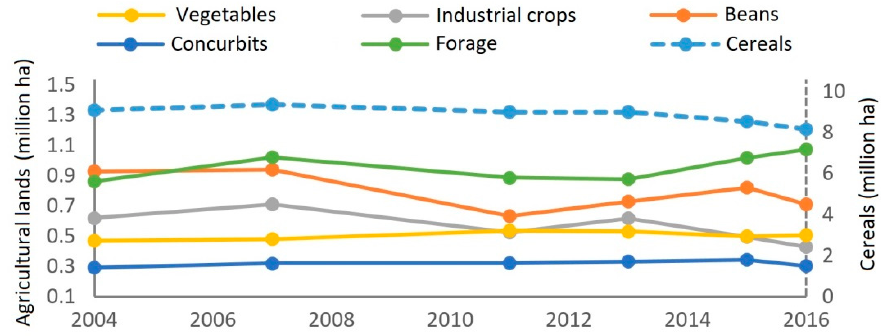
Figure 13. National agricultural GEF resource use, cultivated lands, and crop production in Iran.